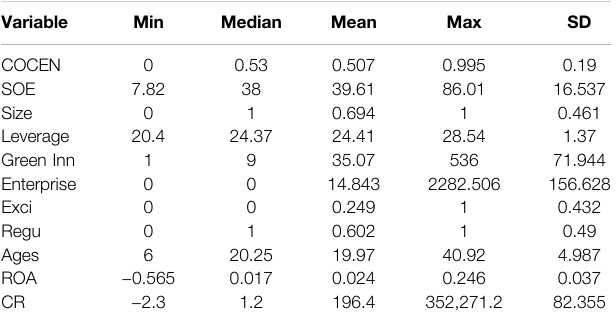
TABLE 2 | Descriptive statistics.